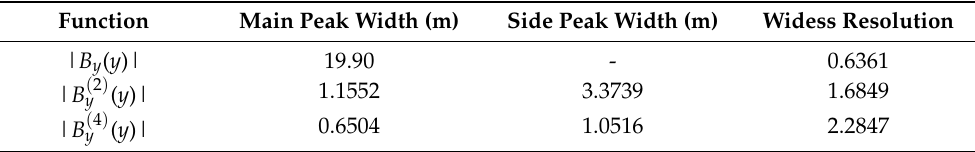
Table 1. Comparison of function shape properties.